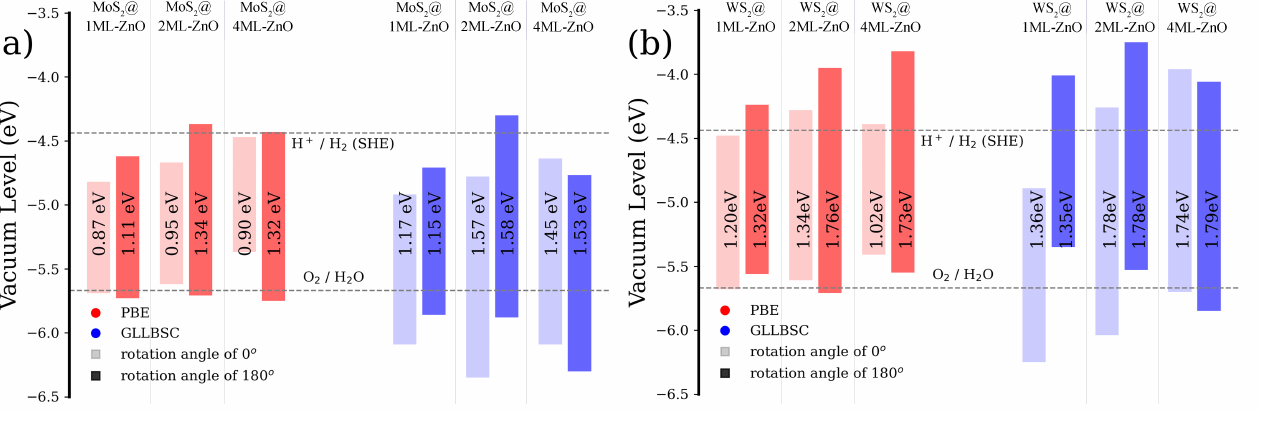
Figure 6. Band edge positions of ( a ) MoS 2 @ZnO and ( b ) WS 2 @ZnO 2D nanocomposites as calculated by means of PBE E XC (red) and GLLBSC E XC (blue) with respect to the water splitting redox levels. The light and dark colors stand for the TMD/ZnO rotation angles of 0 ◦ and 180 ◦ ,